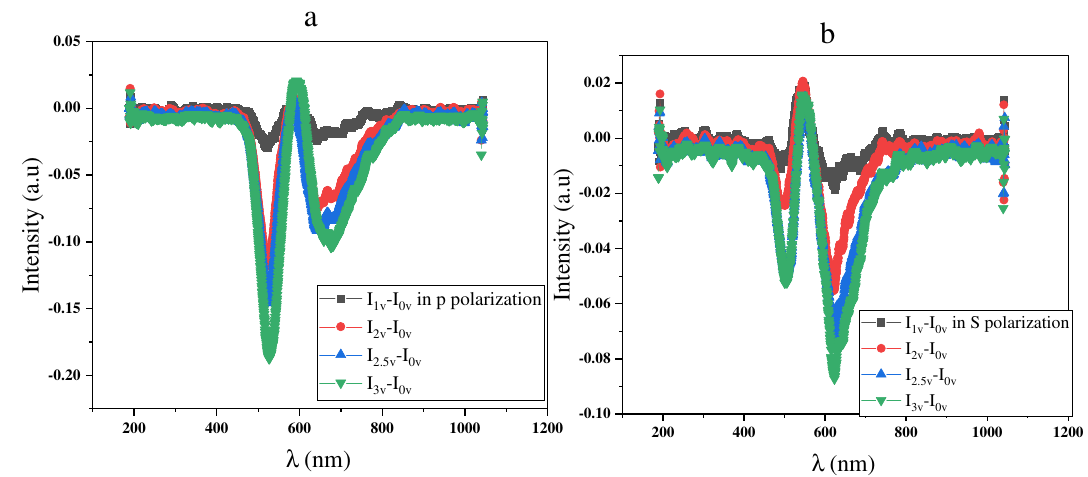
Figure 4. Show the measurement of the activity of the cells without STZ ( a ) with P polarization ( b ) with S (IR) and the Insulin-like growth factor-1 receptor (IGF-1R) signaling (IIR) are markedly disturbed in the central nervous system (CNS) of Alzheimer’s disease patients 37,38 . Furthermore, injection of the STZ will decrease glucose expression of GLUT-2 39 , reduce the expression of insulin receptors 40 , decrease the levels of phosphorylated GSK- 3 14 , and induces insulin resistance 41,42 . Increased apoptosis 43,44 . Insulin resistance occurs when the cell’s tissues fail to respond to the insulin. Moreover, binding the STZ to the insulin receptor will decrease the neuron’s activity. The neuron activity is done by doping Na + channels or opening K + channels. Since the electrical double layer is primarily affected by these variations in K + and Na + in neurons, it serves as the primary modulation source